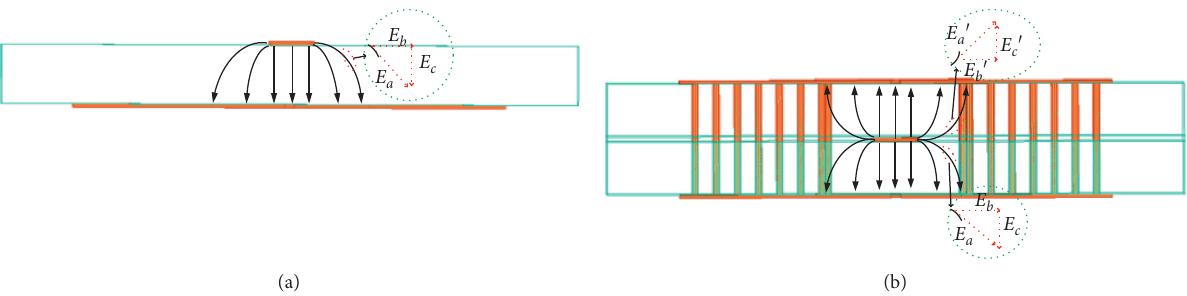
Figure 5: Electric field distribution of the antenna on the top view. (a) Microstrip structure. (b) Stripline